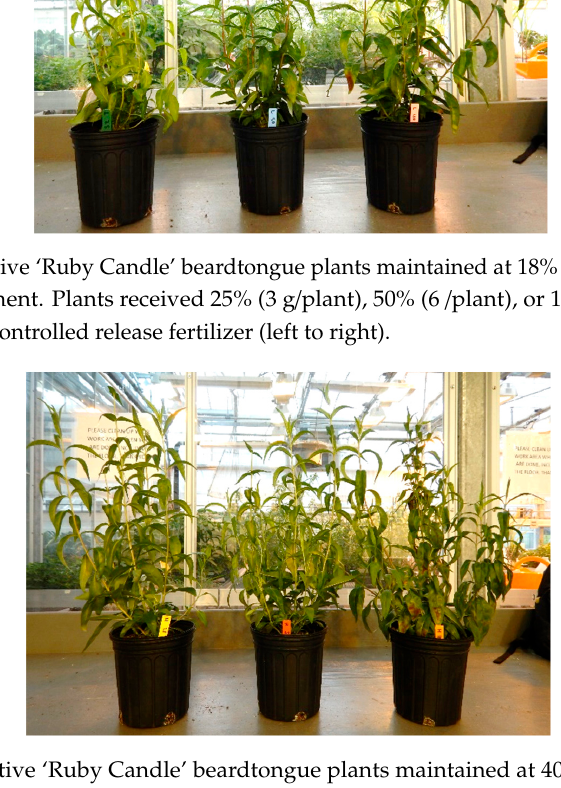
Figure 2. Representative ‘Ruby Candle’ beardtongue plants maintained at 40% VWC content at the conclusion of the 73 day experiment. Plants received 25% (3 g / plant), 50% (6 / plant), or 100% (12 g / plant) of the medium bag rate of controlled release fertilizer (left to